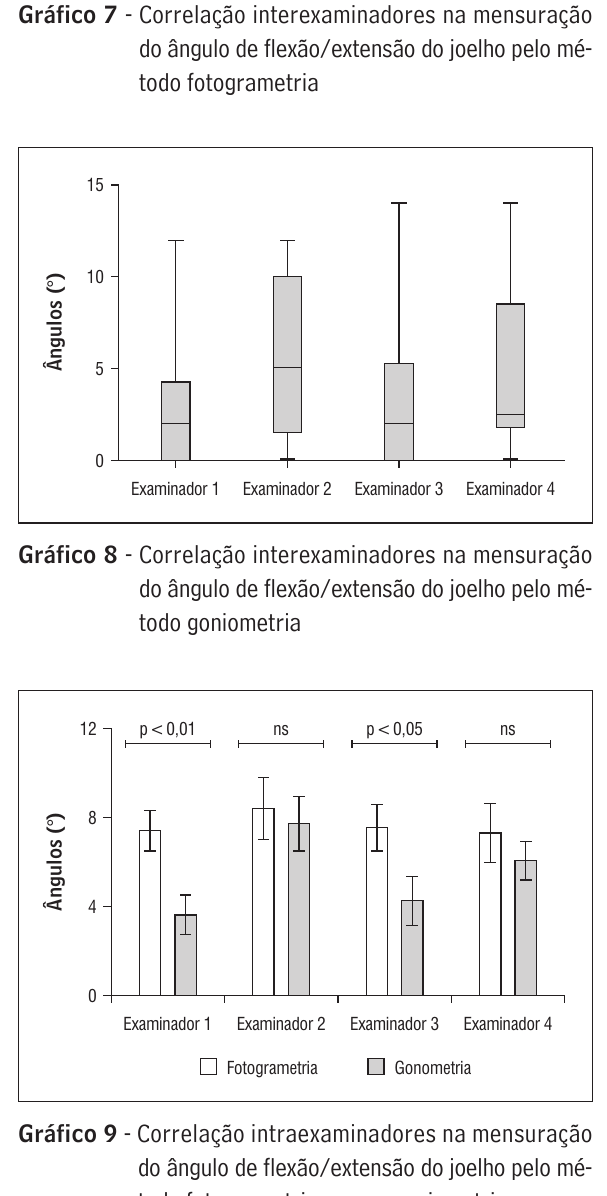
Legenda: *ns = não signi fi cativo (nível de signi fi cância de alfa <